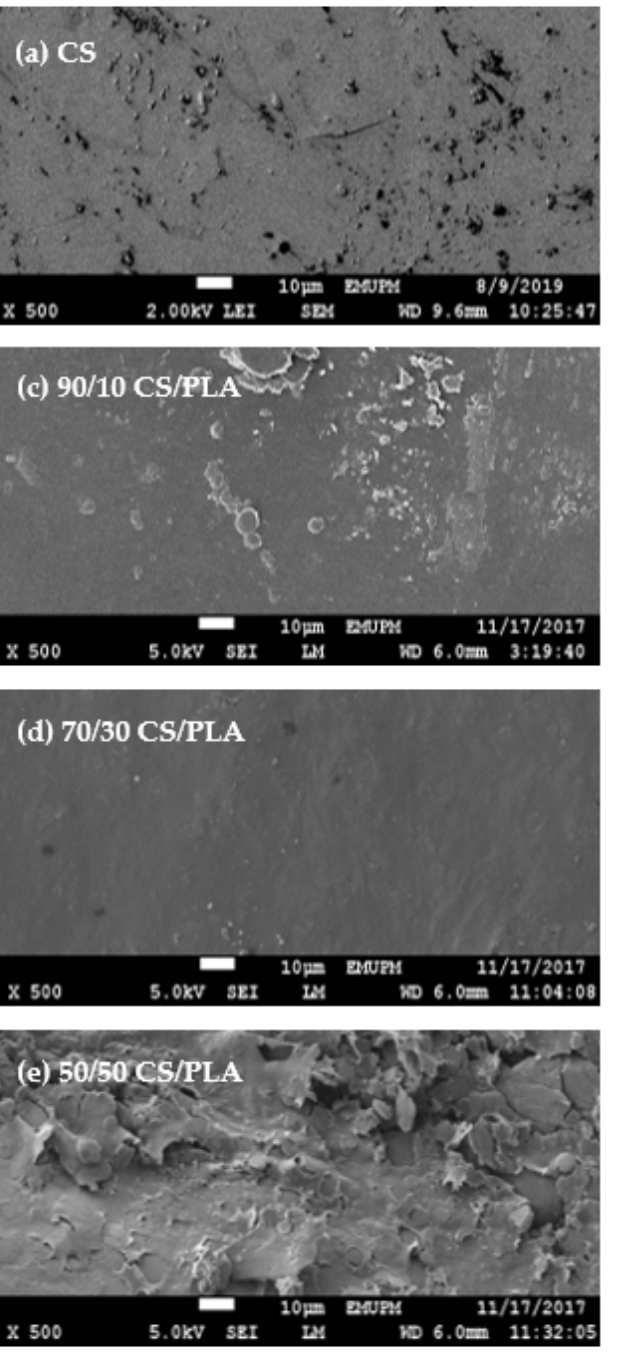
Figure 2. SEM images of composites ( a ) CS, ( b ) PLA, ( c ) 90/10 CS/PLA, ( d ) 70/30 CS/PLA, ( e ) 50/50 CS/PLA, ( f ) 90/10 CS/PLA-GO, ( g ) 70/30 CS/PLA-GO and ( h ) 50/50 CS/PLA-GO.